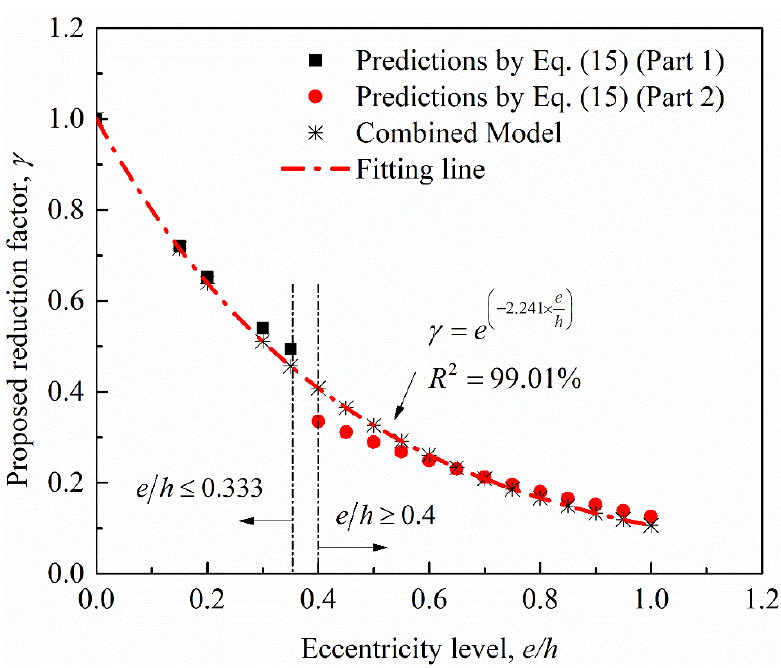
Figure 11. Relationship between the calculated reduction factor and the eccentricity ratio for the unconfined RC specimens summarized in Table 2. Table 6. Comparison between reduction in tested and predicted peak strengths for selected unconfined RC columns tested under different eccentric loading